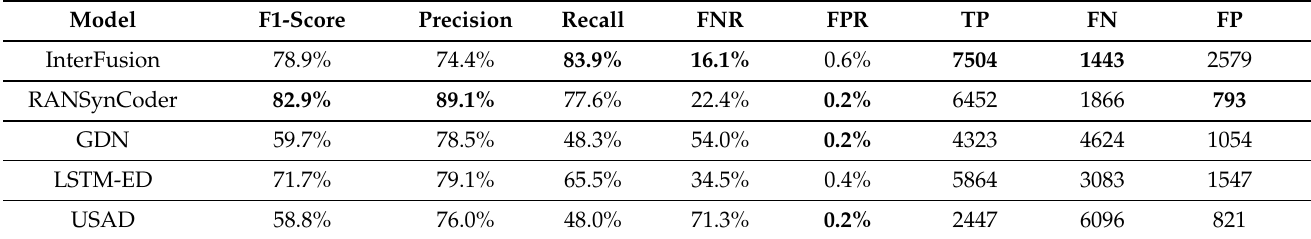
Table 6. Performance of anomaly detection models for the HAI dataset.